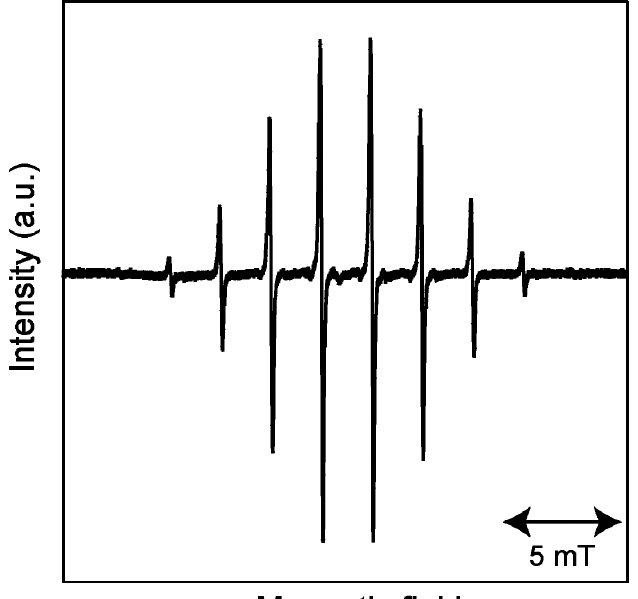
Figure 4. ESR spectrum after annealing at 260 K for 150 hours in the γ -ray-irradiated isobutane hydrate (D 2